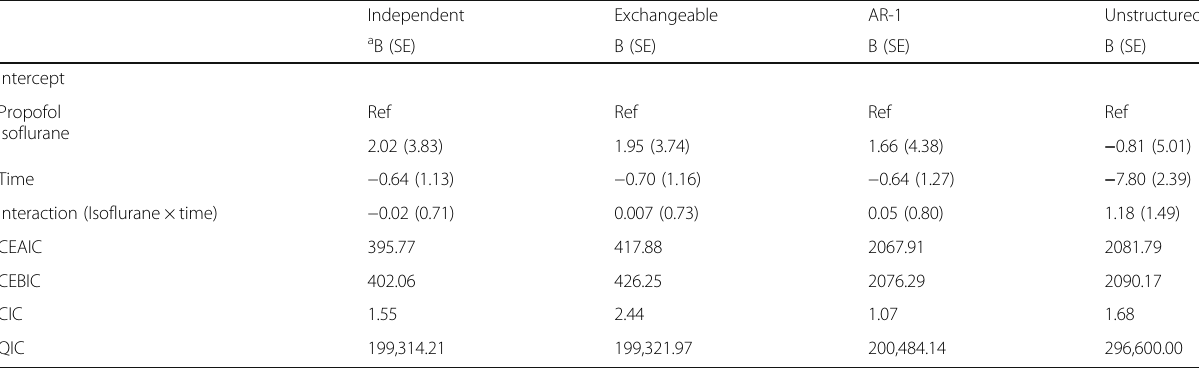
Table 3 Results of fitting GEE model, EAIC, and EBIC criteria for BIS outcome